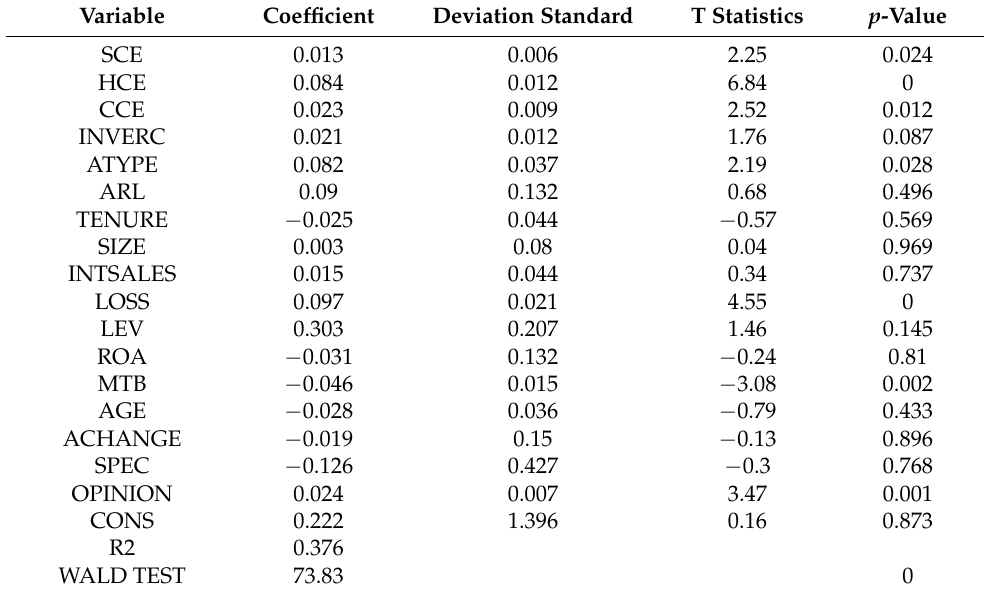
Table 14. The results of estimating the fourth model using the fixed-effects method. Variable